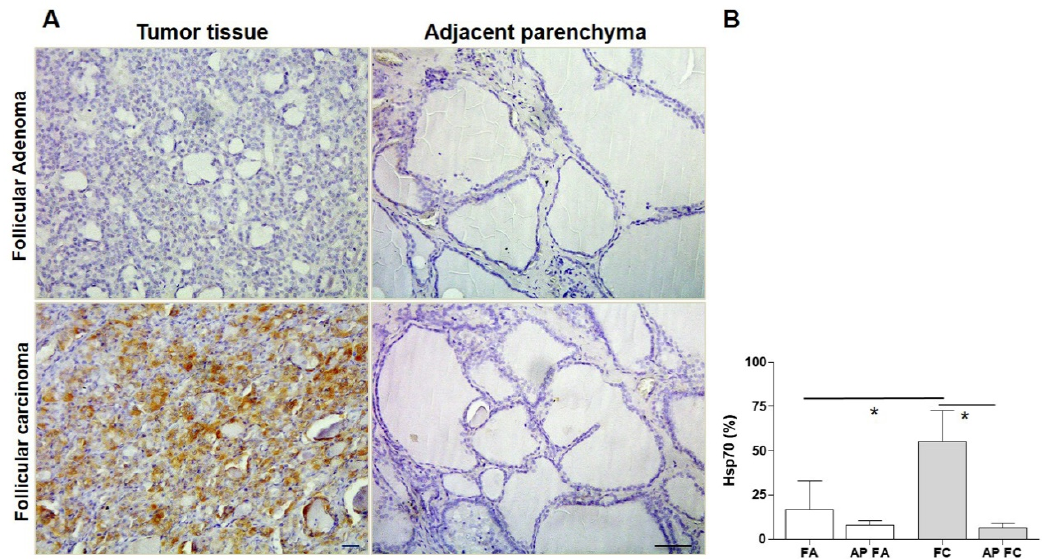
Figure 3. Hsp70 Immunohistochemistry. ( A ) Representative images of immunohistochemical results for Hsp70. Magnification 200×; scale bar 100 μm. ( B ) The histogram shows statistical results for the immunohistochemical evaluation for Hsp70 in follicular adenoma (FA), adjacent parenchyma of follicular adenoma (AP FA), follicular carcinoma (FC) and adjacent parenchyma of follicular carcinoma (AP FC). Data are presented as the mean + SD. * p ≤